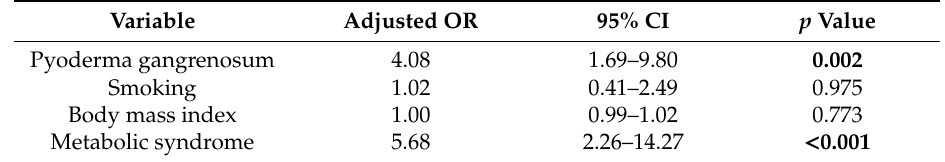
* Adjusting for all the covariates listed in Table 3. Abbreviations: CI, confidence interval. Bold: significant values.